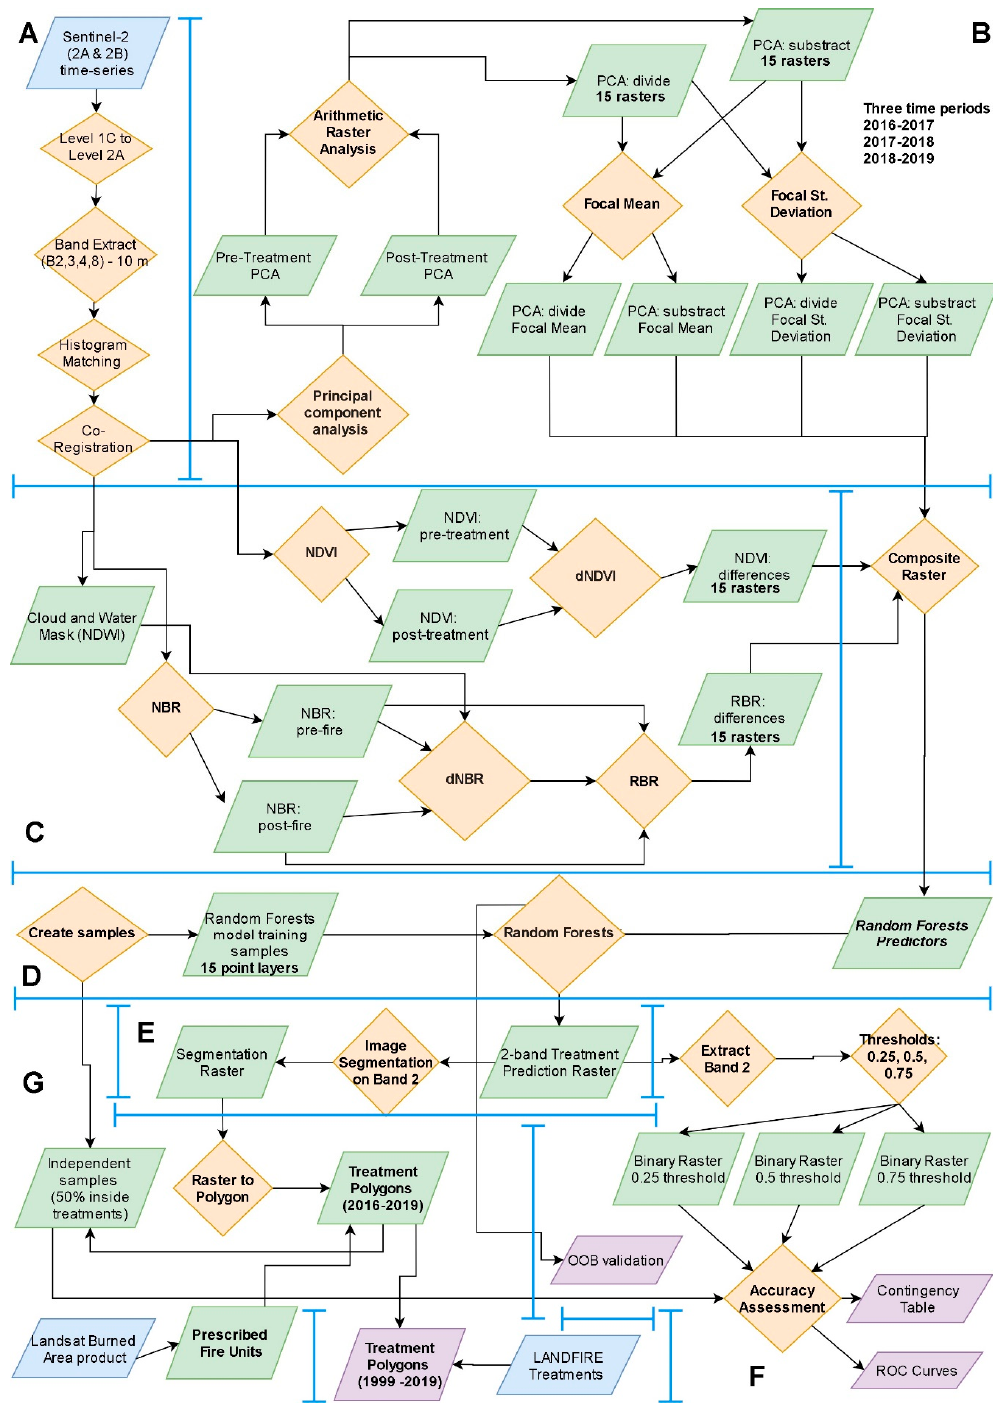
Figure 3. Methodological flowchart of the proposed solution to detect fuel treatments. Blue rectangle: Input; Orange diamond: Process; Green rectangle: Intermediate Dataset; Purple rectangle: Output. ( A ): Satellite Images and Preprocessing; ( B ): Principal Component Analyses; ( C ): Vegetation Indices; ( D ): Random Forests; ( E ): Image Segmentation; ( F ): Accuracy Assessment; ( G ): Fuel Treatment Polygons.